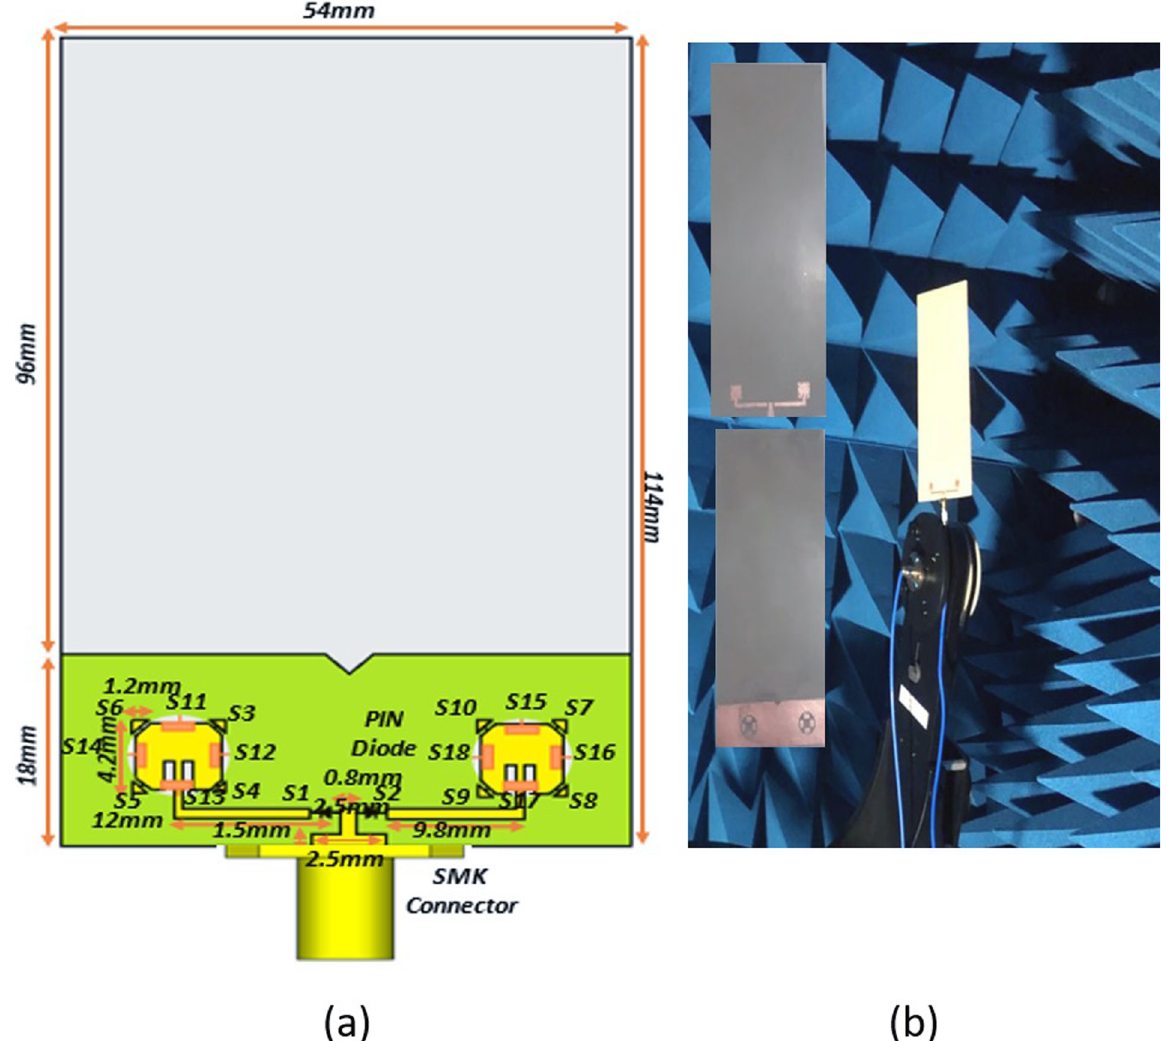
Fig 2. Hybrid reconfigurable antenna designed geometry. (a) Proposed Hybrid Model. (b) fabricated prototype.